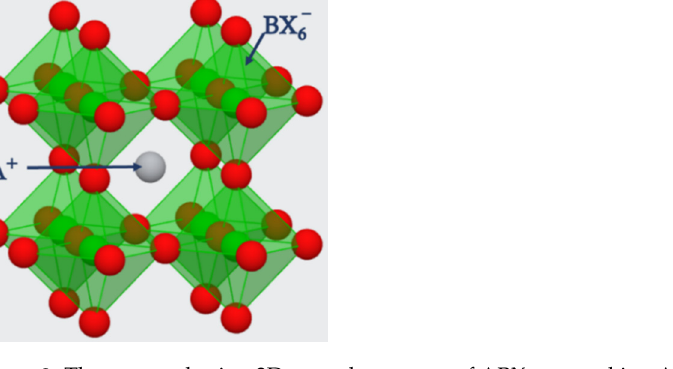
Figure 2. The corner sharing 3D crystal structure of ABX 3 perovskite. A ⁺ ions embedding the voids of octahedral BX 6 ̅ by sitting in their cavities. of octahedral BX − by sitting in their 6